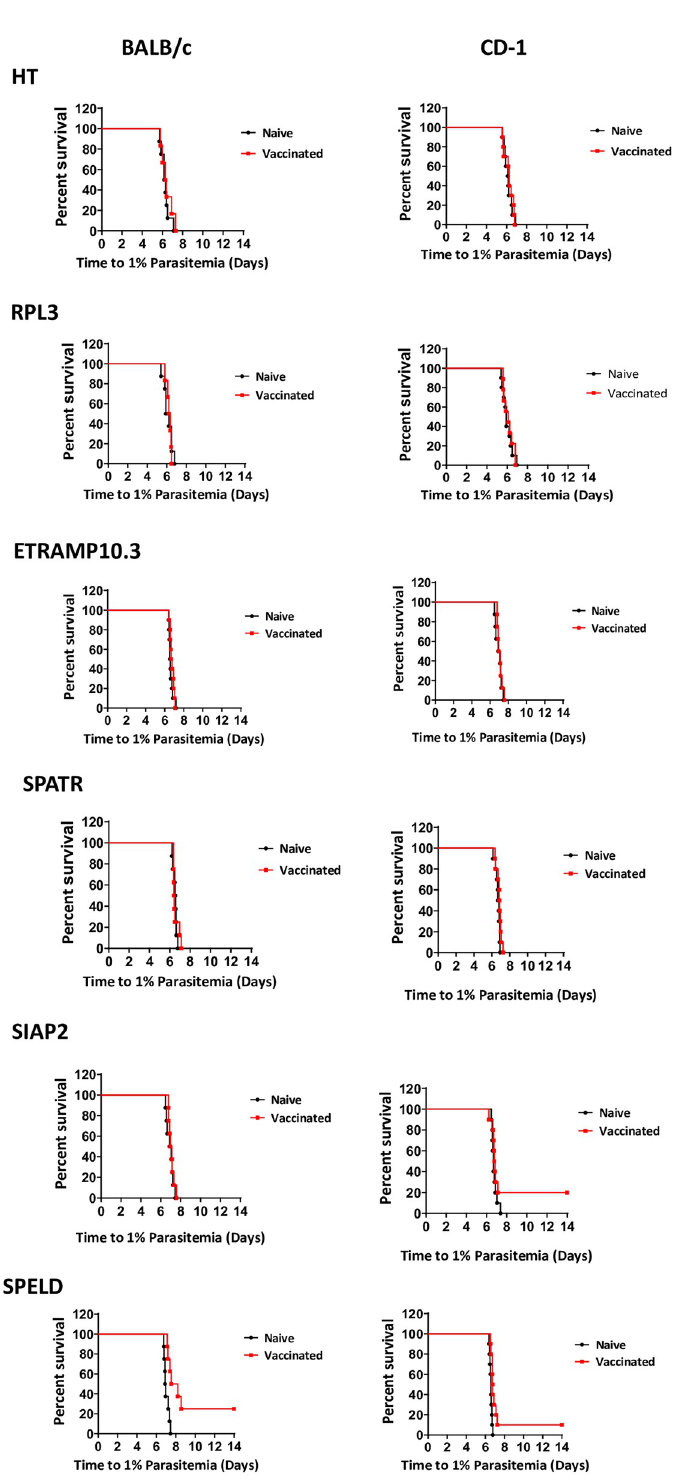
Fig 4. Protective immunity of viral-vectored P . falciparum antigens. Protective immunity in mice immunized with ChAd63- and MVA viral-vectored P . falciparum proteins as determined by the (delay in) the day to blood stage patency, i.e. the day to reach 1% parasitemia after challenge with chimeric P . berghei sporozoites expressing the P . falciparum proteins. Eight immunized and eight na ï ve BALB/c mice and ten immunized and ten na ï ve CD-1 mice were challenged with 10 3 chimeric sporozoites by intravenous injection. The Kaplan-Meier curves illustrate the time to